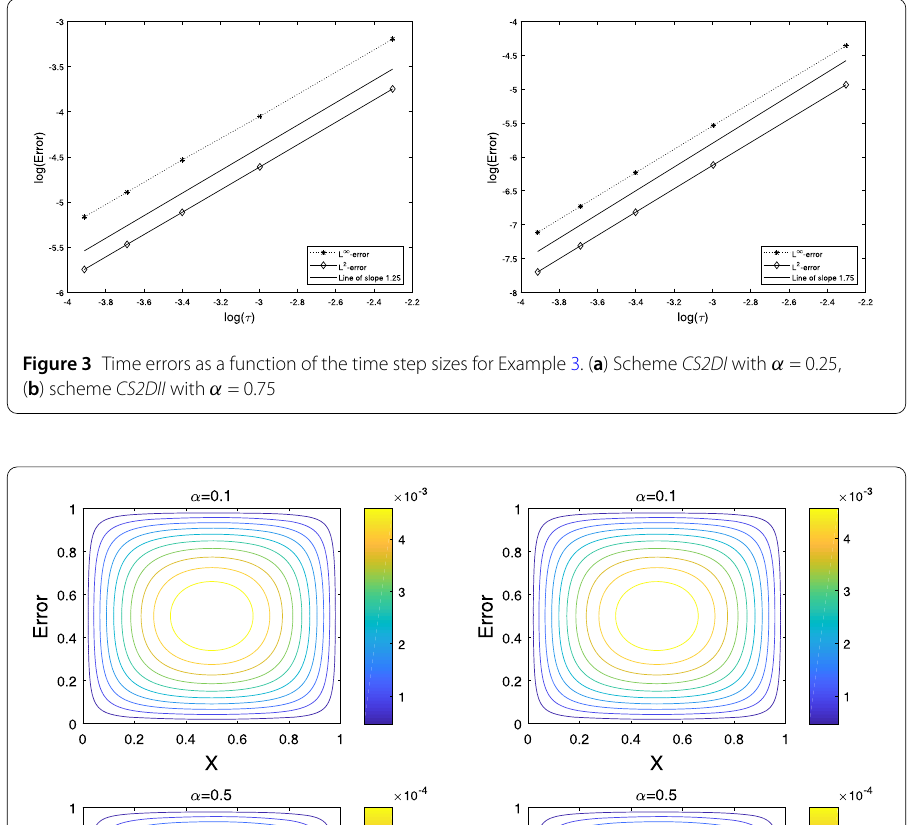
in Fig. 4. From these results, we find that two methods have the same temporal conver- gence rates, and the convergence rate of scheme CS2DII is lower than 3– α because of the splitting